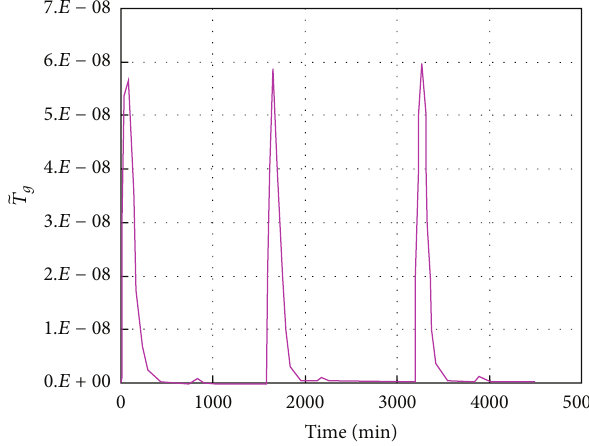
Figure 6: Simulation results of the granular entropy temperature evolution under repeated thermal